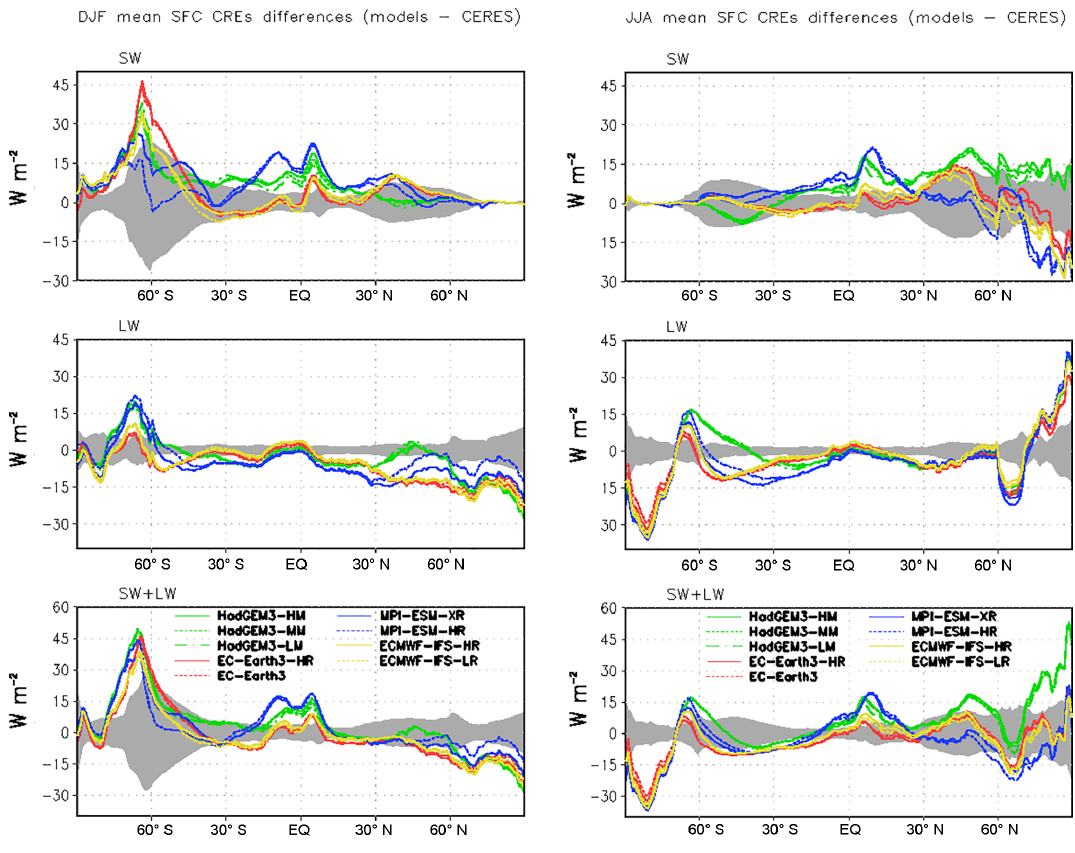
Figure 4. Same as Fig. 1 but at the